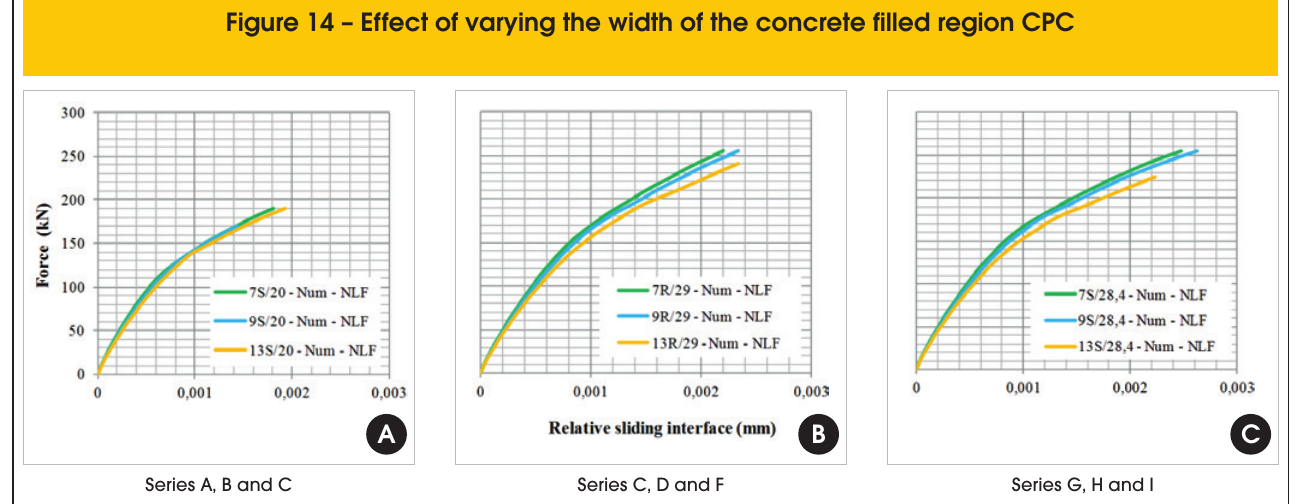
Figure 14 – Effect of varying the width of the concrete filled region